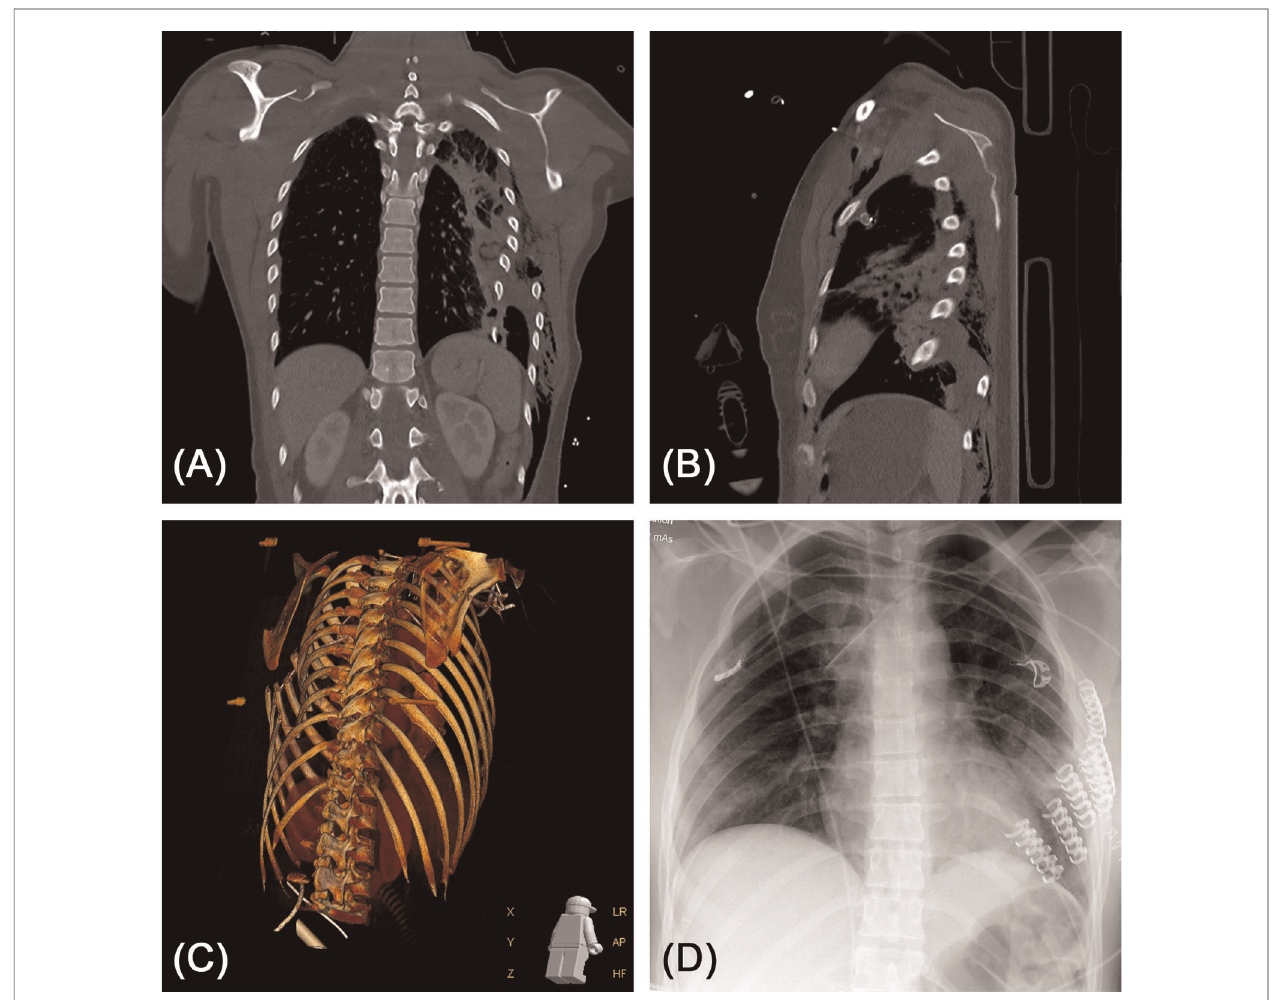
FIGURE 7 | ( A,B ) 26-year-old female patient after suicidal train accident. Computed tomography (coronary and sagittal reconstructions are shown) revealed severely dislocated fractures of all ribs on the left side with laceration of the lung parenchyma and lung contusion. ( C ) 3D volume rendering of the CT dataset. ( D ) Post-operative chest X-ray after stabilization of costae 3 to 8. Laceration of the lung parenchyma was reconstructed by stapler-guided